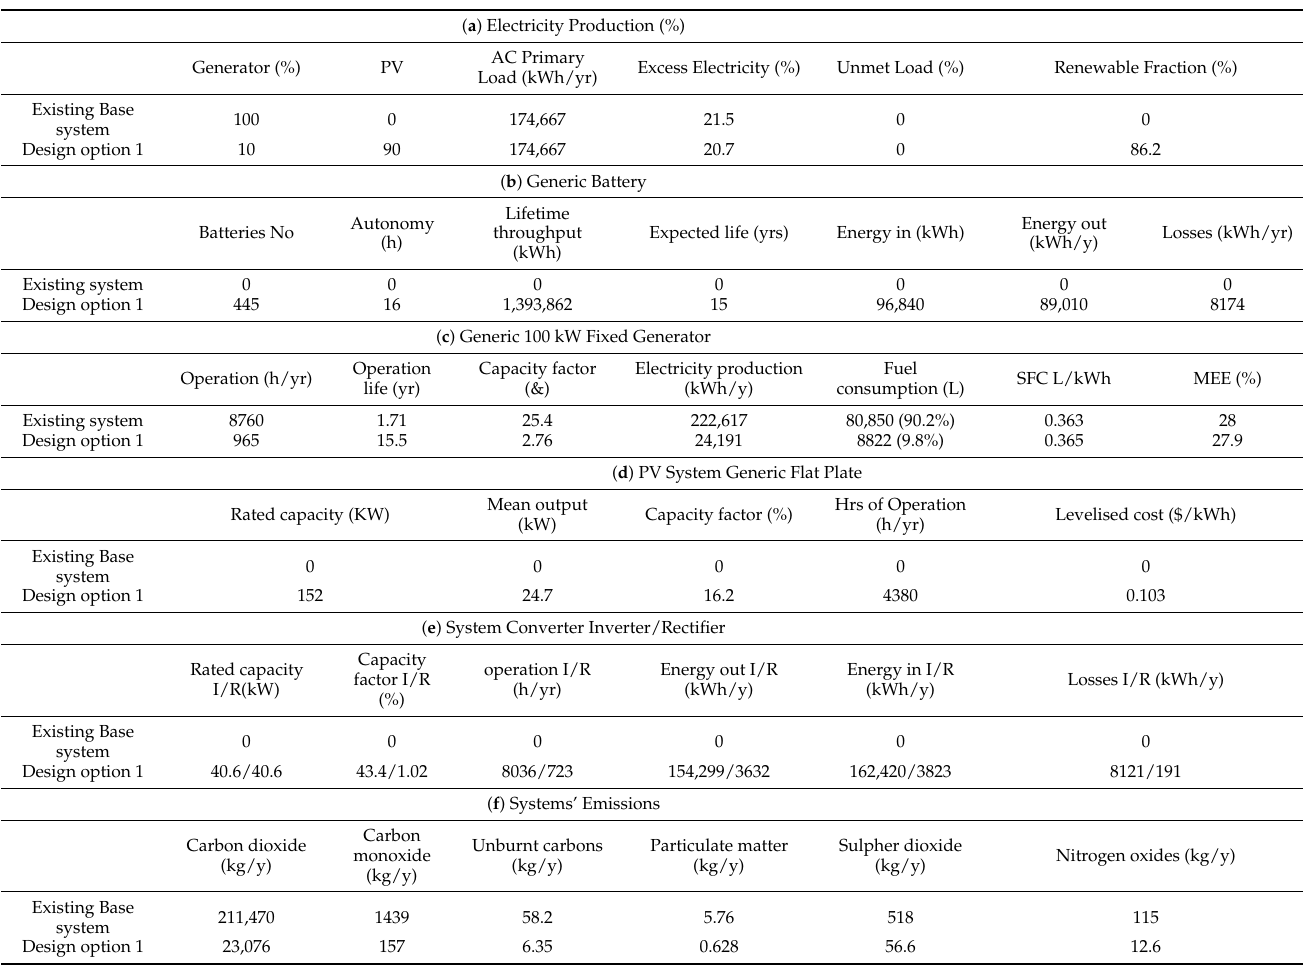
Table 5. ( a – f ): Design option 1 comparing technical parameters of the base system and proposed hybrid system of simulated values.